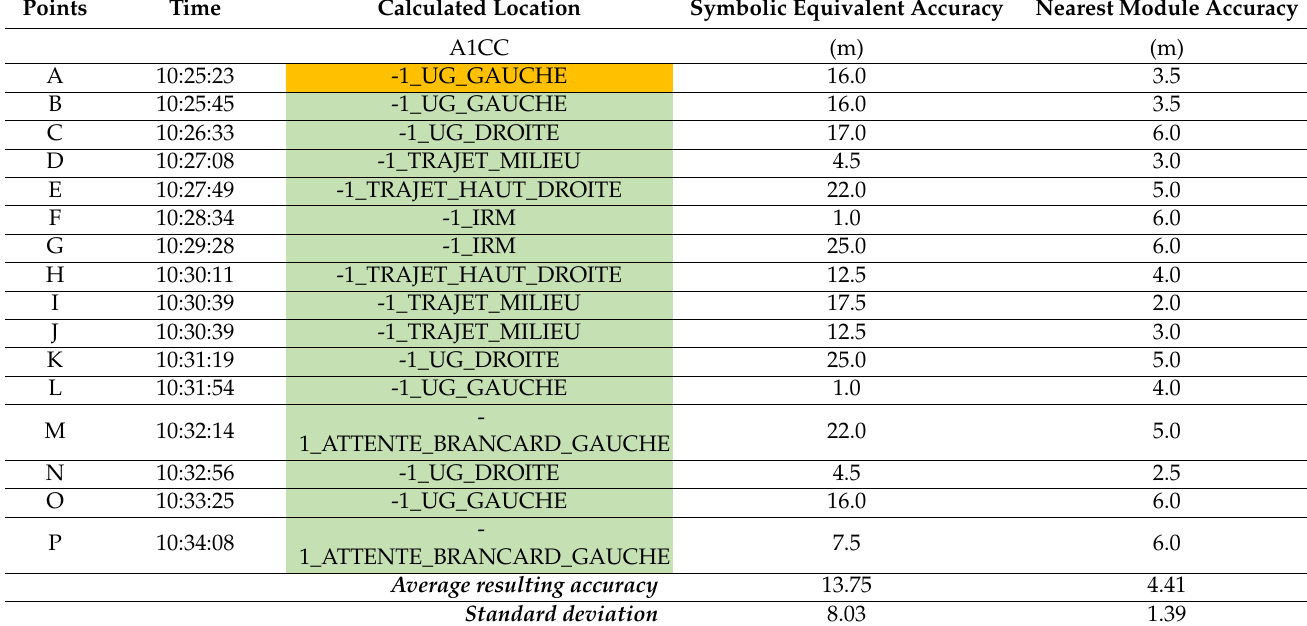
Table 3. Accuracy of the proposed approach with respect to the applied positioning